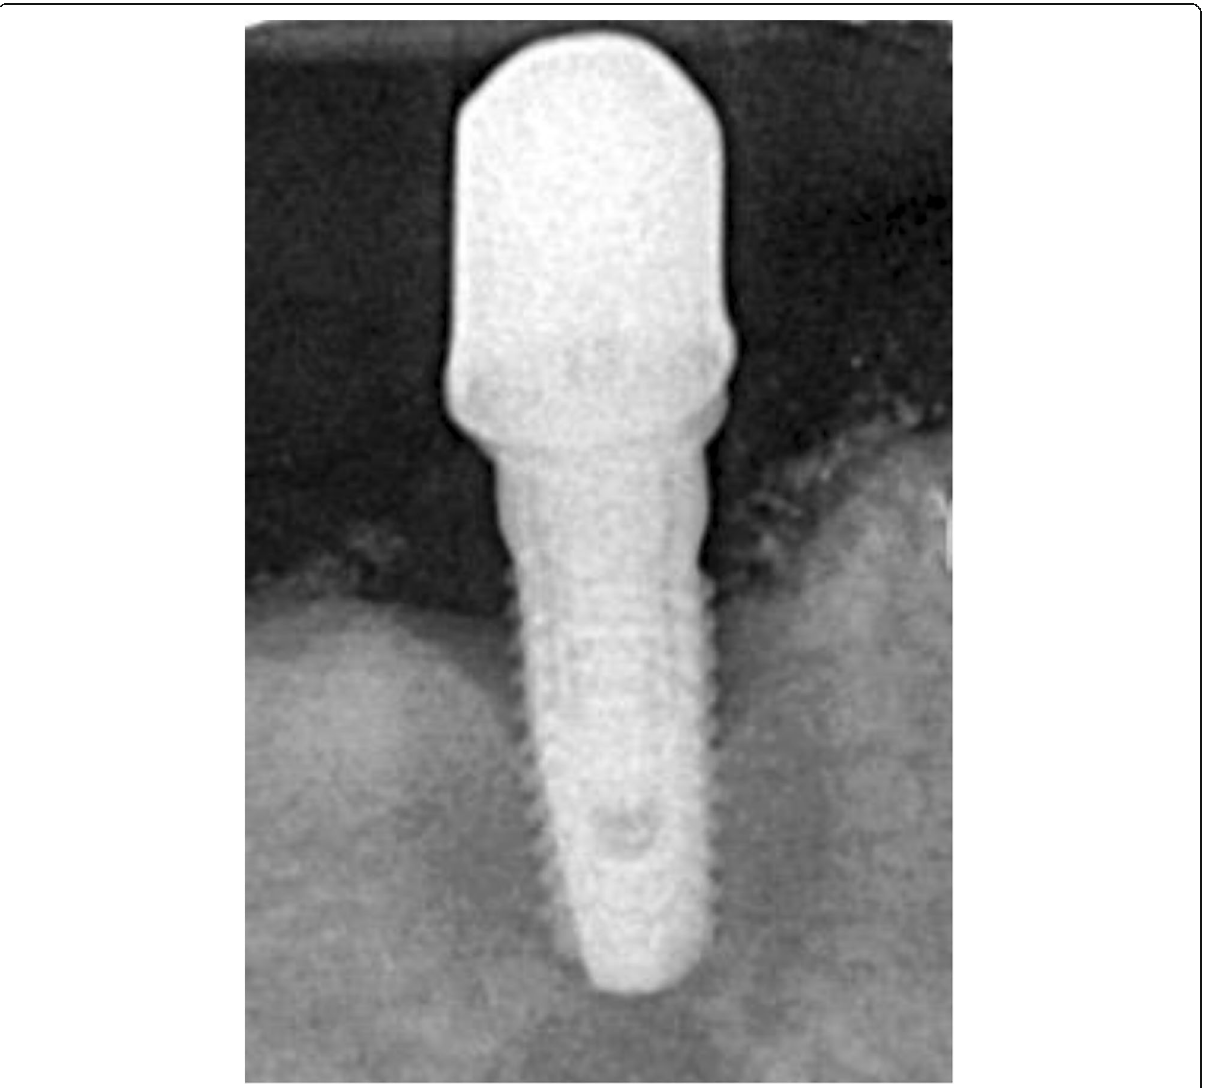
Fig. 13 The intraoral radiograph 6 years after insertion of the superstructure showed horizontal and vertical bone loss at the implant. The crestal bone loss was up to the 6th